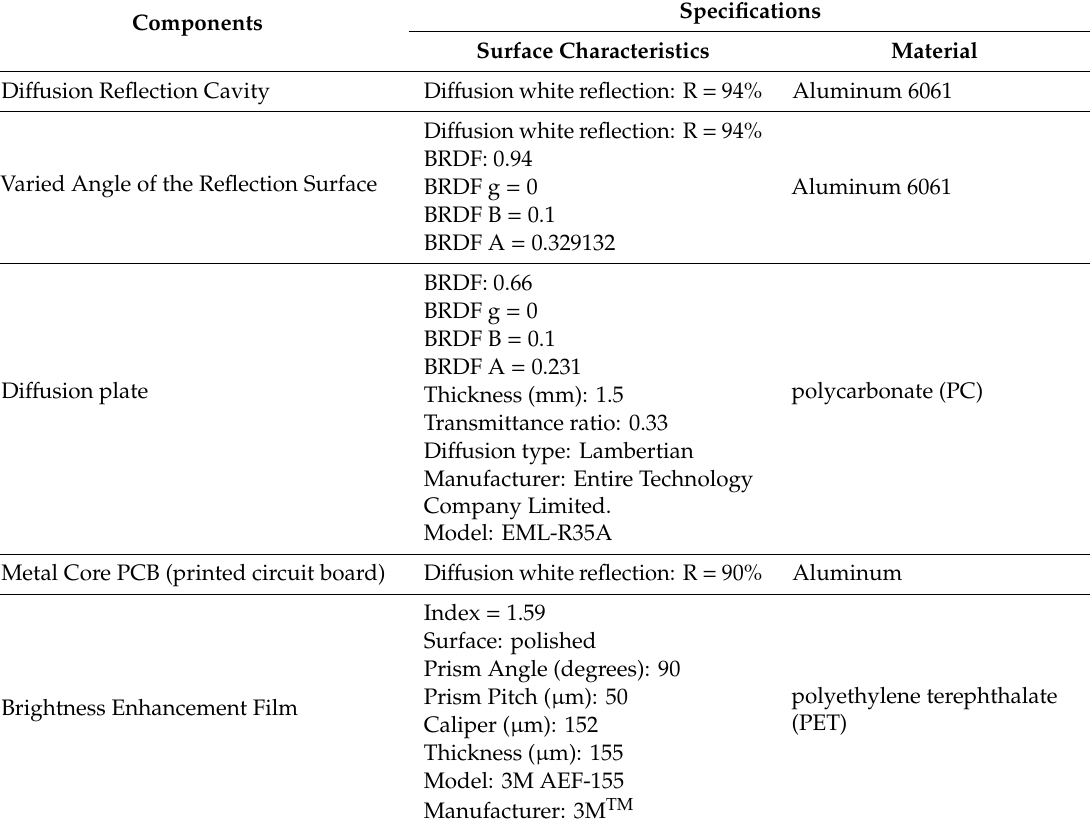
Figure 2. Dimensions of light source module. Table 1. Simulation parameter settings.